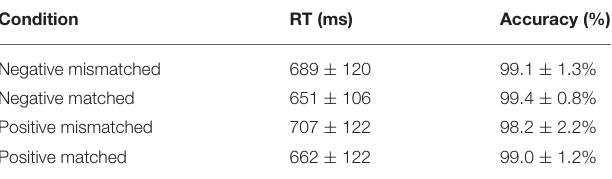
TABLE 2 | Descriptive statistics for behavioral